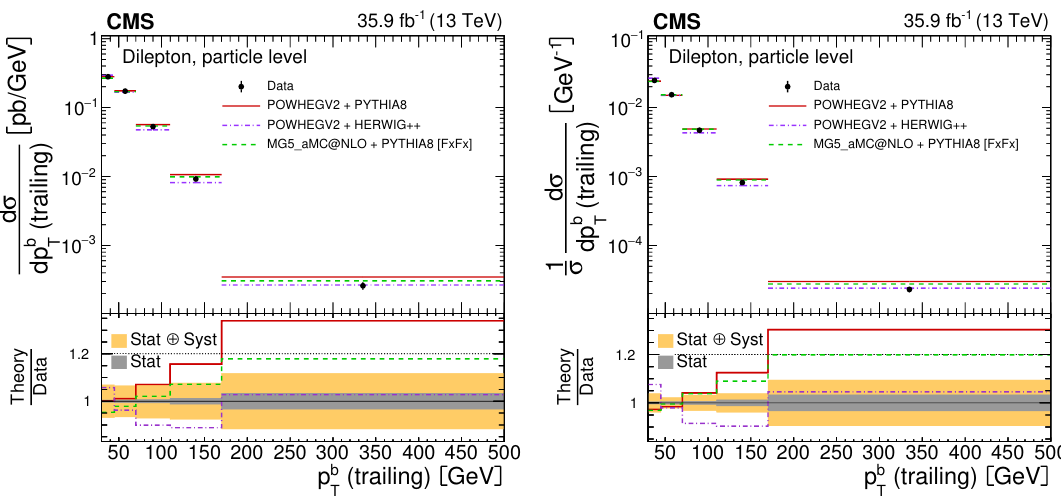
Figure 46 . The di(cid:11)erential tt production cross sections as a function of p b phase space at the particle level are shown for the data (points) and the MC predictions (lines). The vertical lines on the points indicate the total uncertainty in the data. The left and right plots correspond to absolute and normalised measurements, respectively. The lower panel in each plot shows the ratios of the theoretical predictions to the data. The dark and light bands show the relative statistical and total uncertainties in the data, respectively.